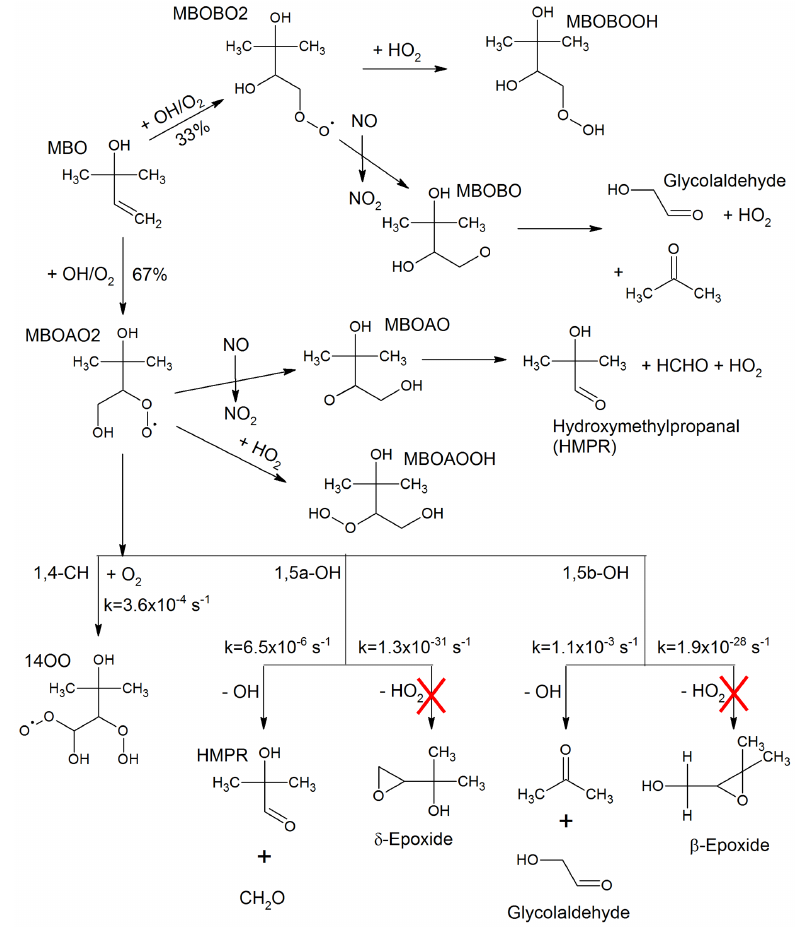
Figure 1. Simplified MBO OH-oxidation reaction scheme as described in the MCM version 3.3.1, including 1,4 and 1,5 H-shift reactions and their rate coefficients at 1013hPa and 298K as suggested by Knap et al. (2016). These H-shift reactions were added to the MCM version 3.3.1 kinetic model for a sensitivity test excluding the ones forming the epoxides (marked with the red